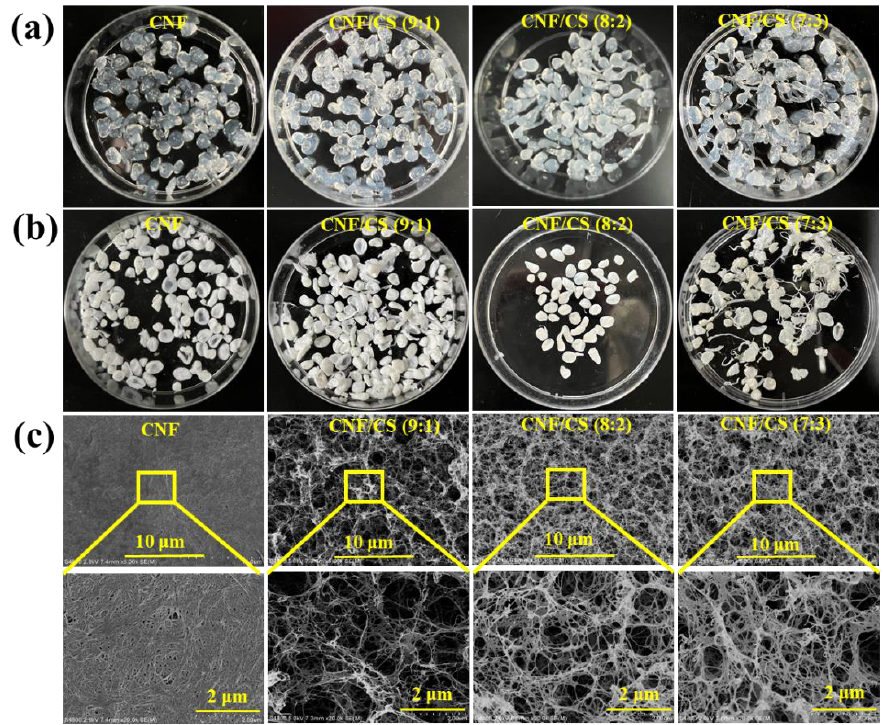
Figure 2. ( a ) Digital images of regenerated CNF beads and CNF/CS composite beads; ( b ) Freeze-dried CNF and CNF/CS beads; ( c ) SEM images of CNF and CNF/CS beads.